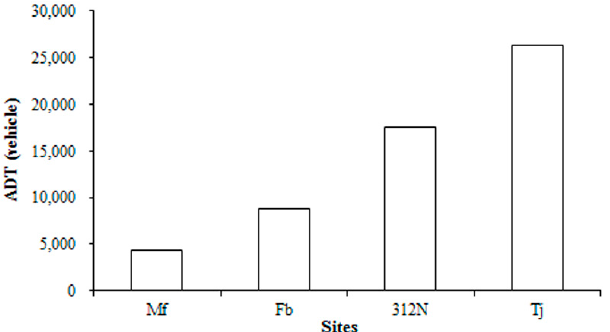
Figure 4. Traffic statistics for each of the study sites (Mf: Minfeng Road, Fb: Fengbin Road, 312N: 312 National Road, Tj: Tongjiang Avenue) ADT: average daily traffic volume.